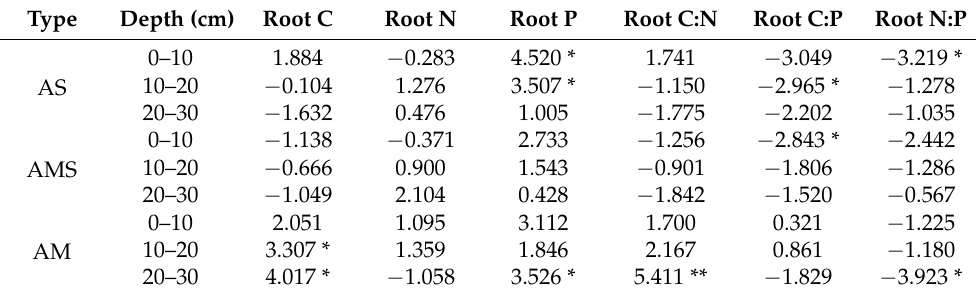
Table 1. T value of root C, N, P, C:N, C:P, and N:P between April and August.